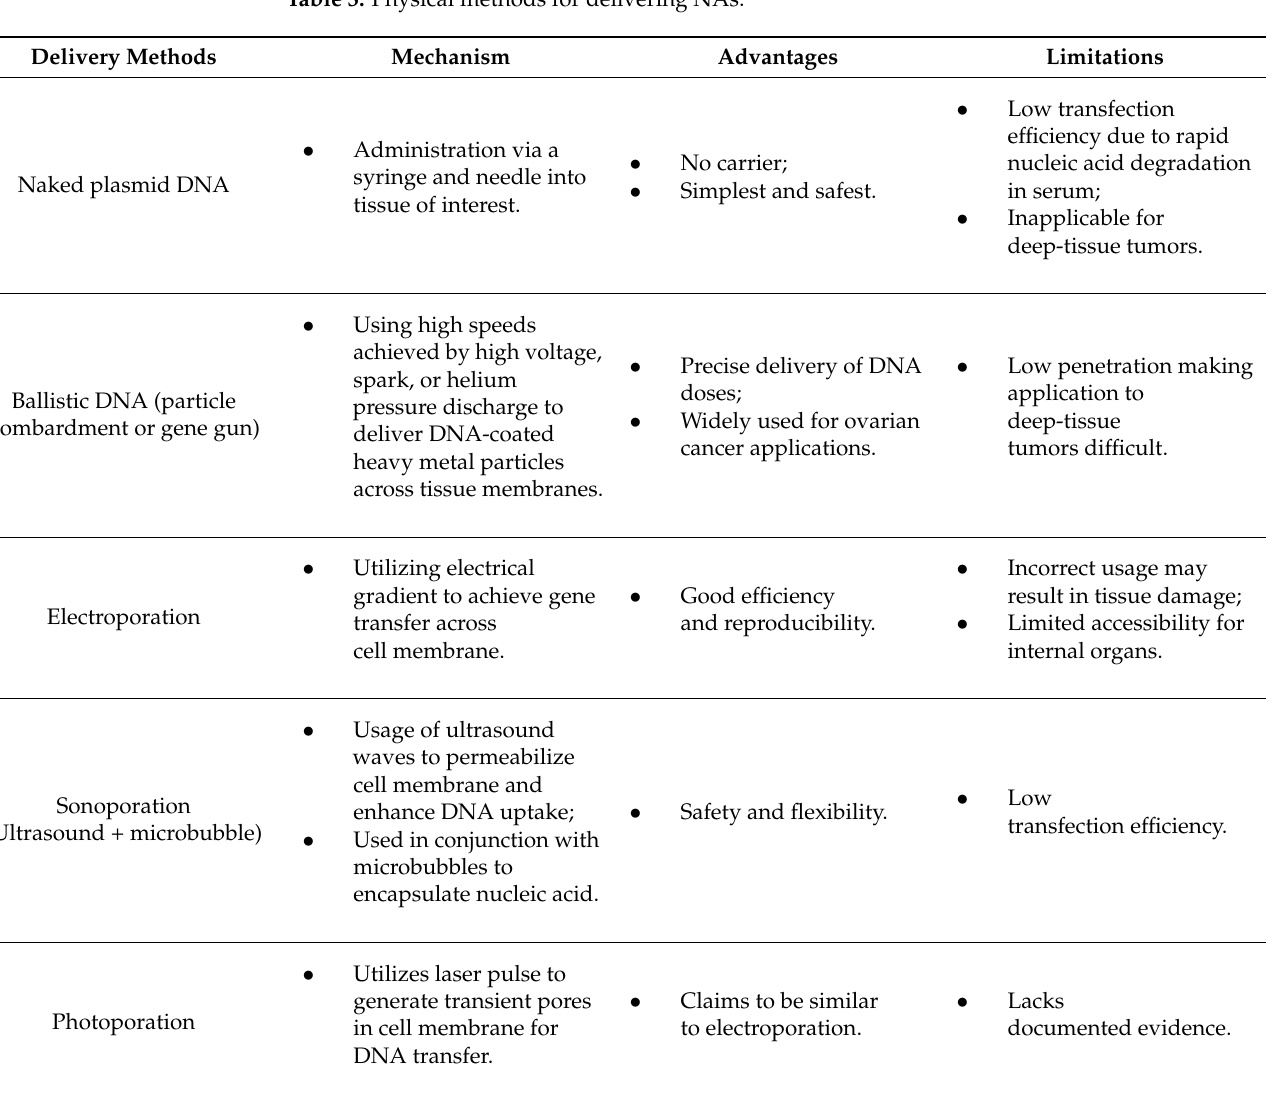
Table 3. Physical methods for delivering